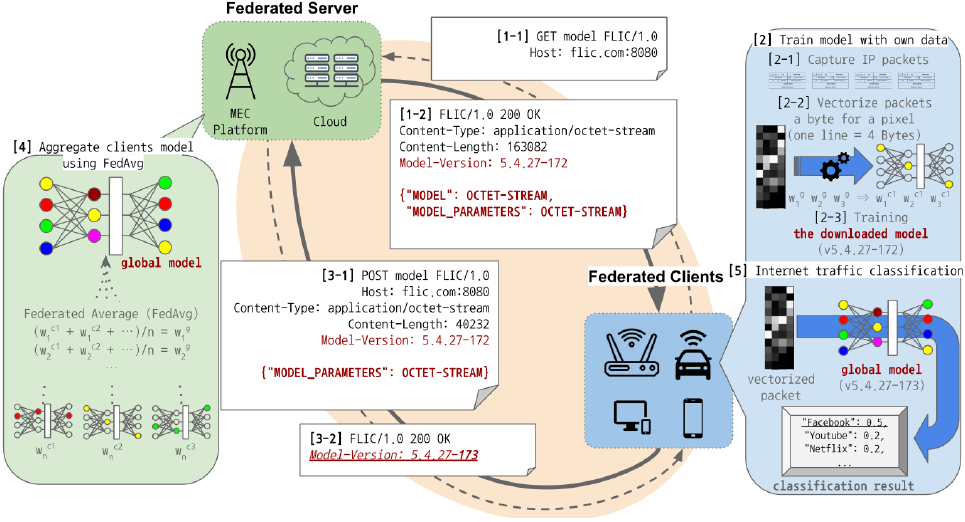
Figure 1. The architecture of federated learning-based Internet traffic classification